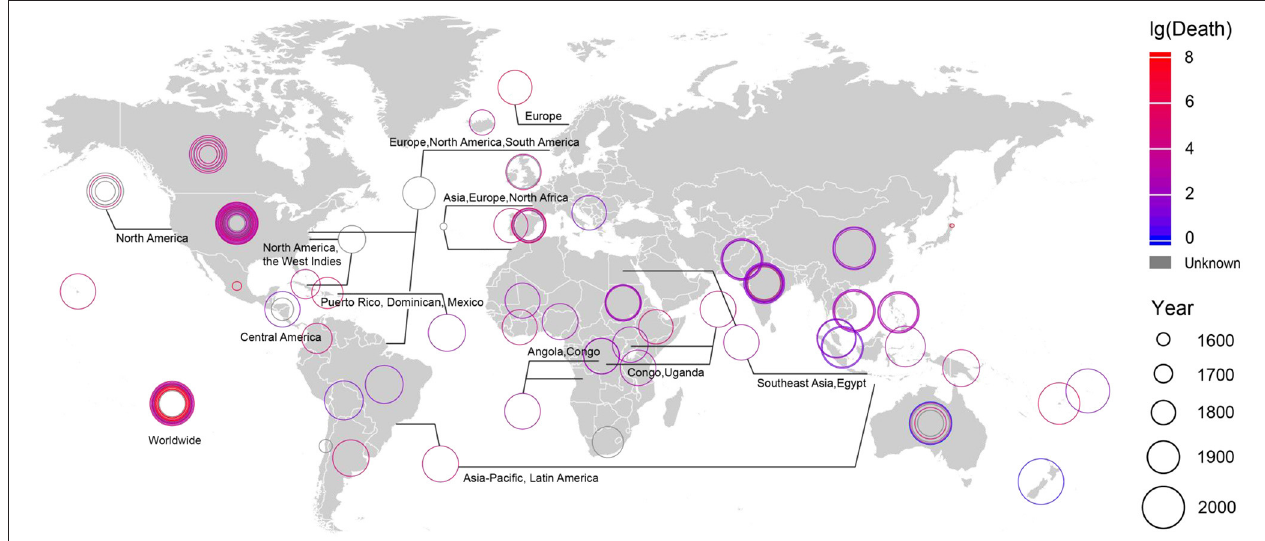
FIGURE 5 | The outbreak time, location and death toll of all viral epidemics on record. See Supplementary Table S1 for detailed